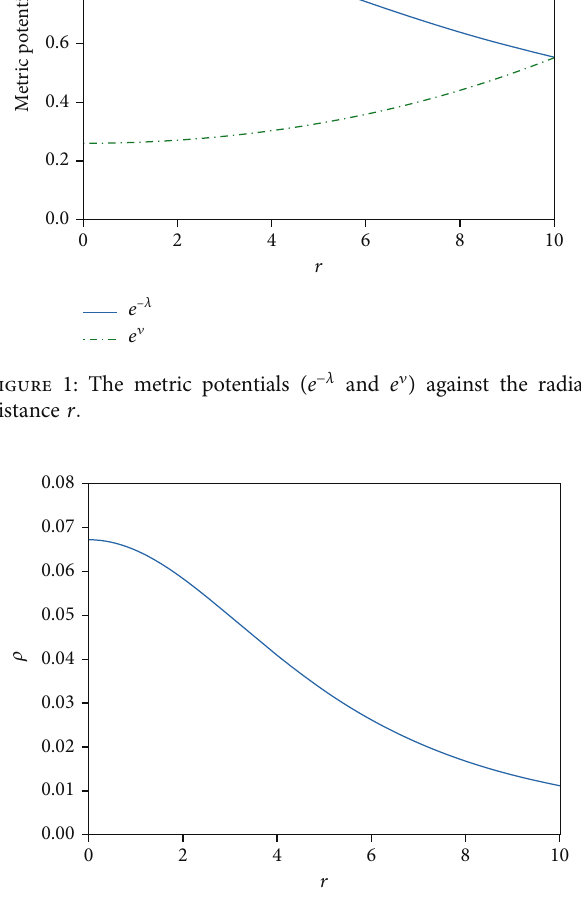
Figure 2: Energy density ρ against the radial distance r